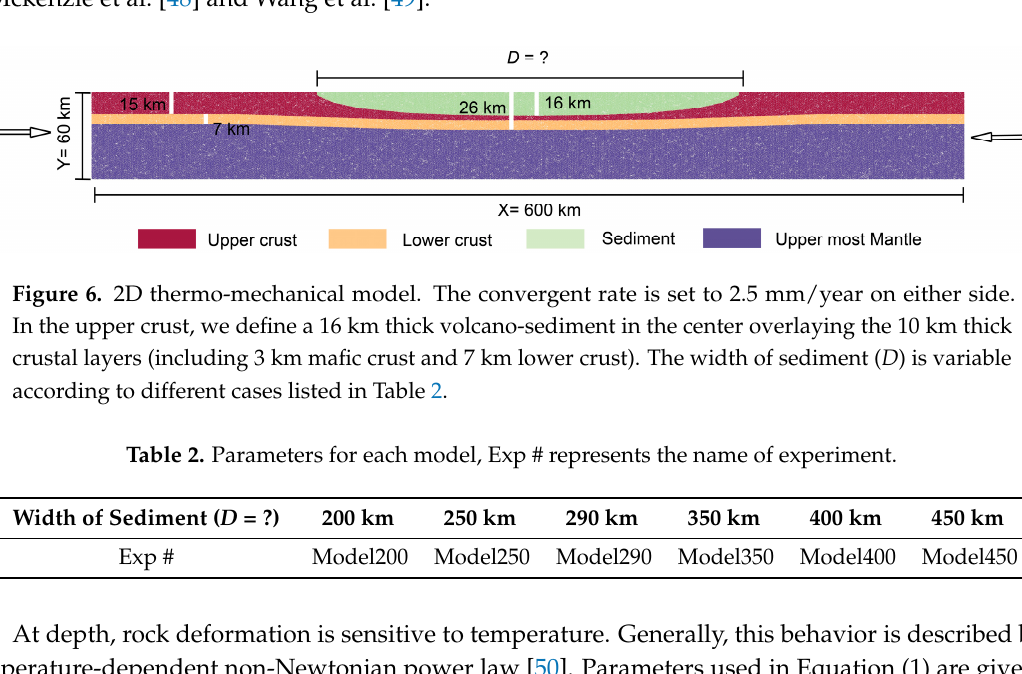
Figure 5. The pressures of initial and final melting of samples are calculated with the PRIMELT3 software [42]. Melt fraction ranges between 0.29 and 0.34. The horizontal axis shows the sample information, corresponding to the “index” row in Table 1. Pi—Pressure of initial melting, Pf—Pressure of final melting.